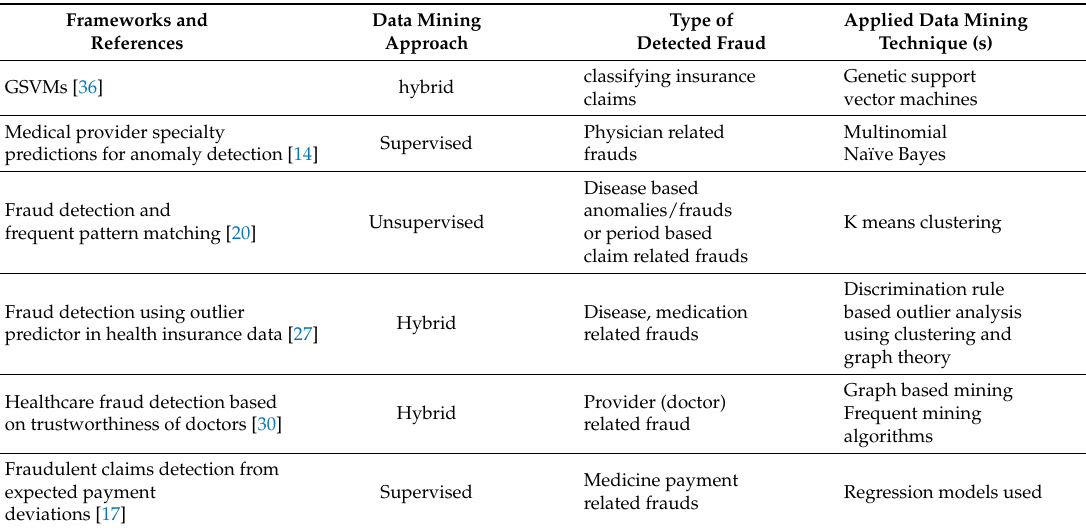
Table 1. Comparison with Existing